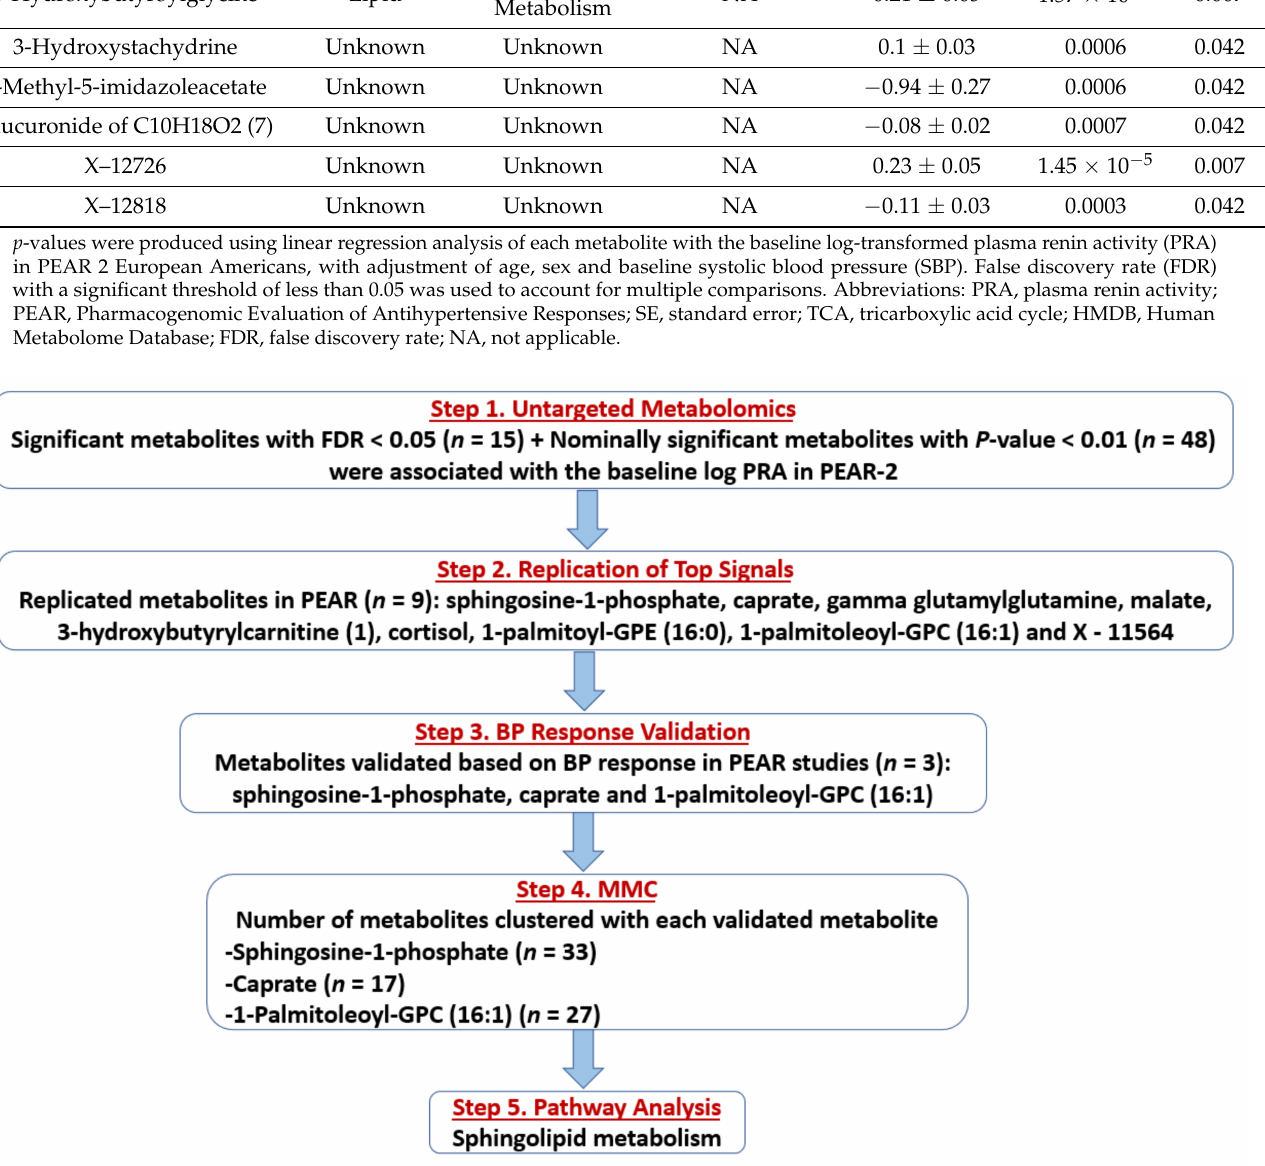
Figure 1. Flow chart showing the flow of the study results. Abbreviations: FDR, false discovery rate; PRA, plasma renin activity; PEAR, Pharmacogenomic Evaluation of Antihypertensive Responses; BP, blood pressure; MMC, Modulated Modularity